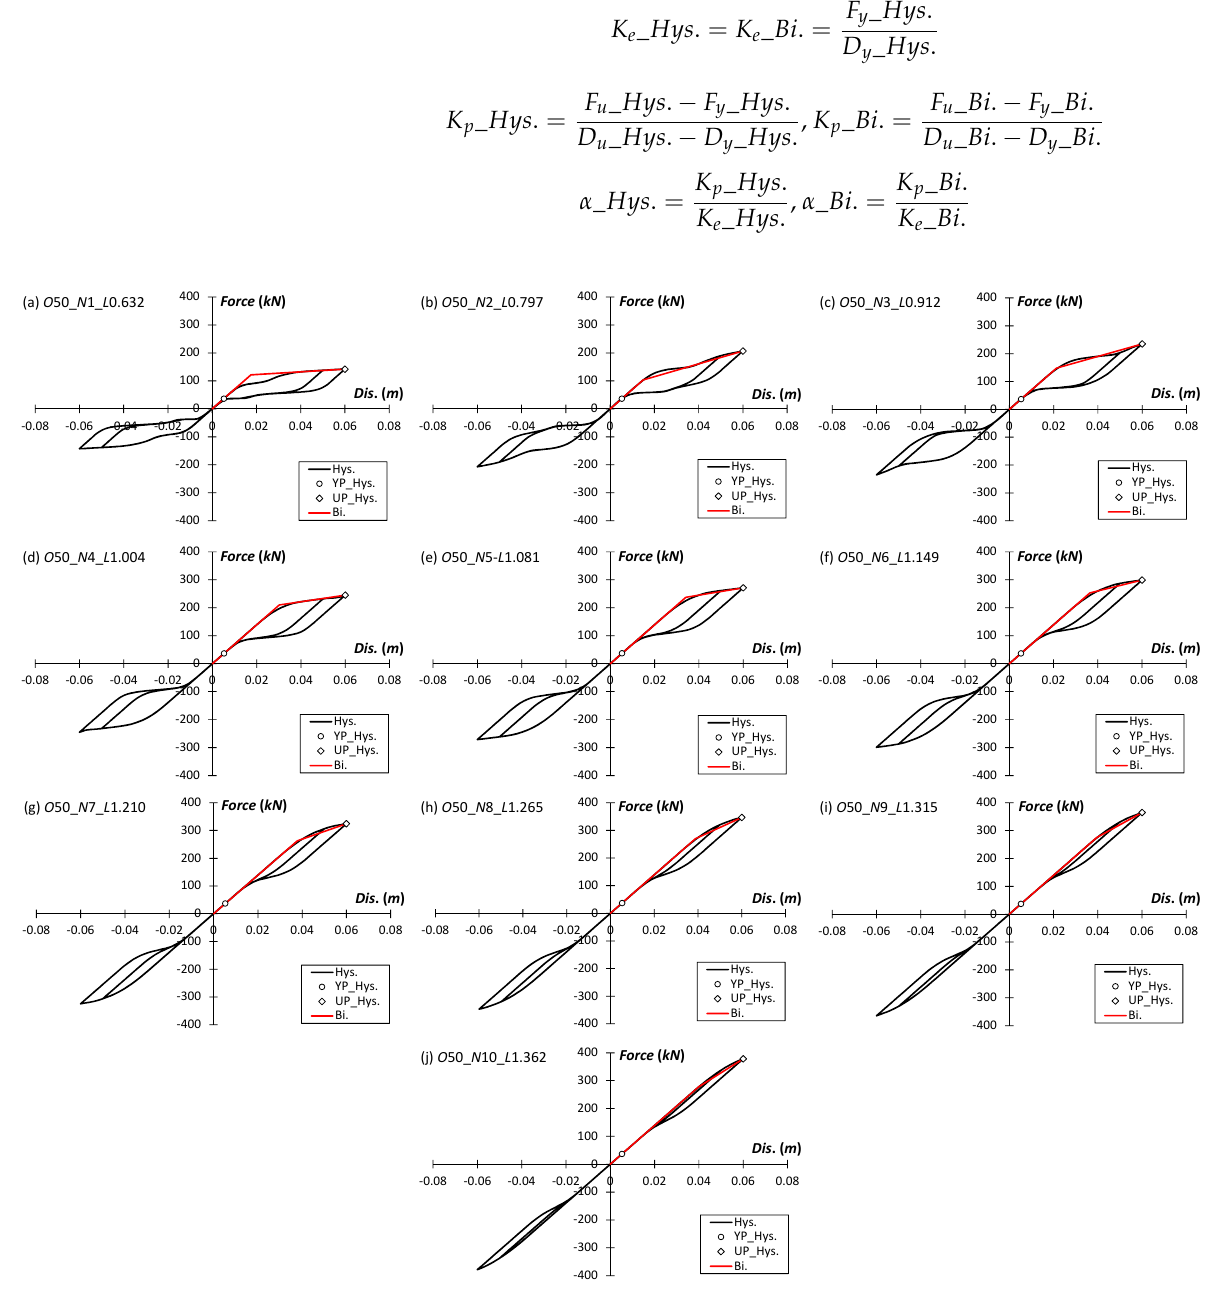
Figure 11. Typical hysteresis curves of SMA-BHD numerical models with 50 mm diameter ( Φ 50) and different number of bars in Set 1: ( a ) one; ( b ) two; ( c ) three; ( d ) four; ( e ) five; ( f ) six; ( g ) seven; ( h ) eight; ( i ) nine; ( j ) ten. Apart from displacement and forces at the first yield ( D y and F y ) and ultimate ( D u and F u ) points, there are additional parameters in hysteresis and bilinear curves that can help in assessing the cyclic behaviour. Parameters such as elastic stiffness ( K e ), post-yield stiff-